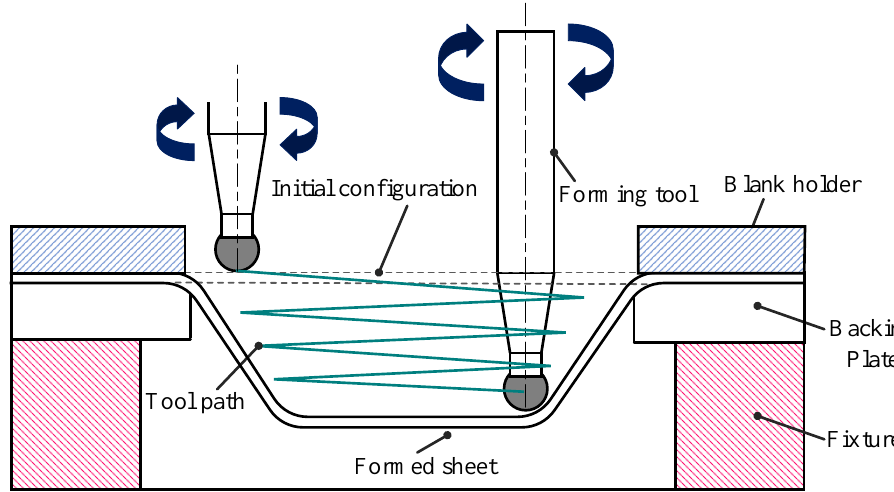
Figure 1. Schematic diagram of the negative incremental forming